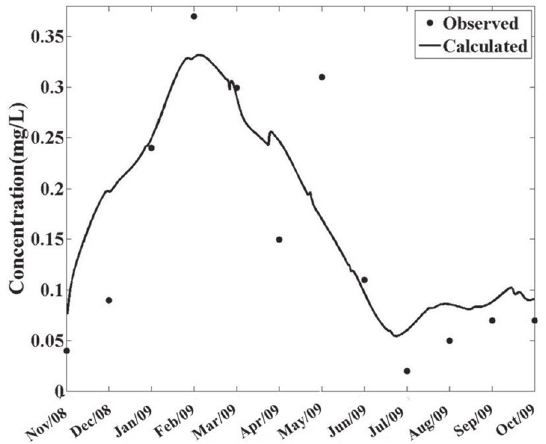
Figure 12 - Comparison between the data observed and calculated data on phosphorus